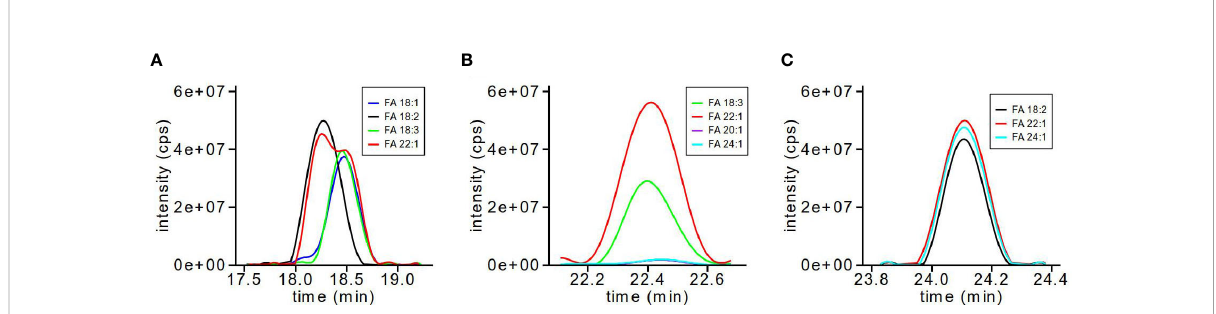
FIGURE 2 TG MRM transitions for FA composition analysis. The XIC for individual TG-FA MRM transitions are overlaid to determine which TG-FA MRMs are used in quanti fi cation and data analysis. TG-58:5 (A) shows two molecular species as 18:2_18:2_22:1 and 18:1_18:3_22:1; TG-62:5 (B) shows two molecular species as 18:3_22:1_22:1 and 18:3_20:1_24:1; TG-64:4 (C) shows one molecular species as